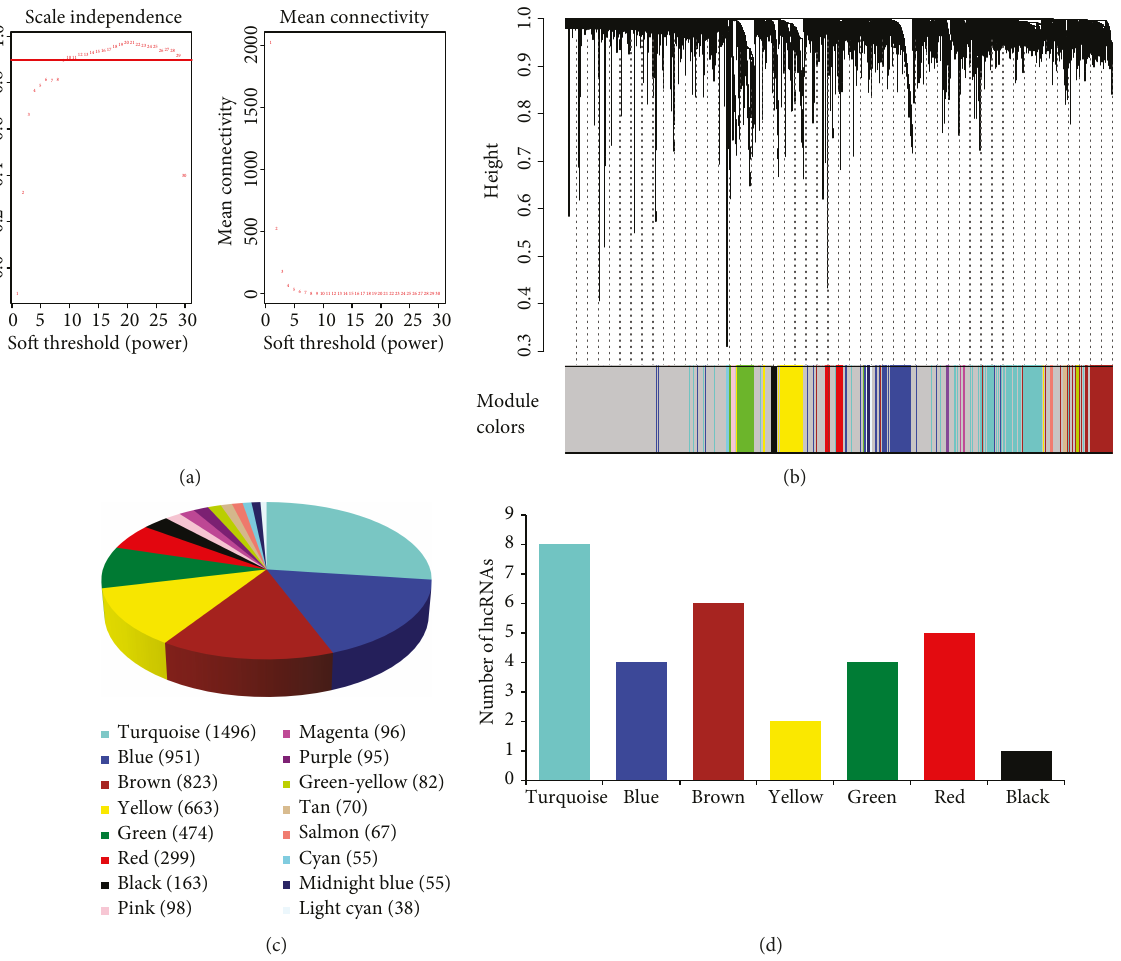
Figure 1: Gene modules detected using the weighted correlation network analysis (WGCNA). (a) Scale-free topology index and mean connectivity were used to determine the soft threshold. (b) Clustering dendrogram of genes. The dissimilarity of genes is based on the topological overlap. The genes are assigned to di ff erent modules and modules are named using di ff erent colors. (c) Number of genes in each module identi fi ed from WGCNA. The numbers in the parentheses represent the number of genes in each module. (d) Number of lncRNAs in the modules containing more than 100